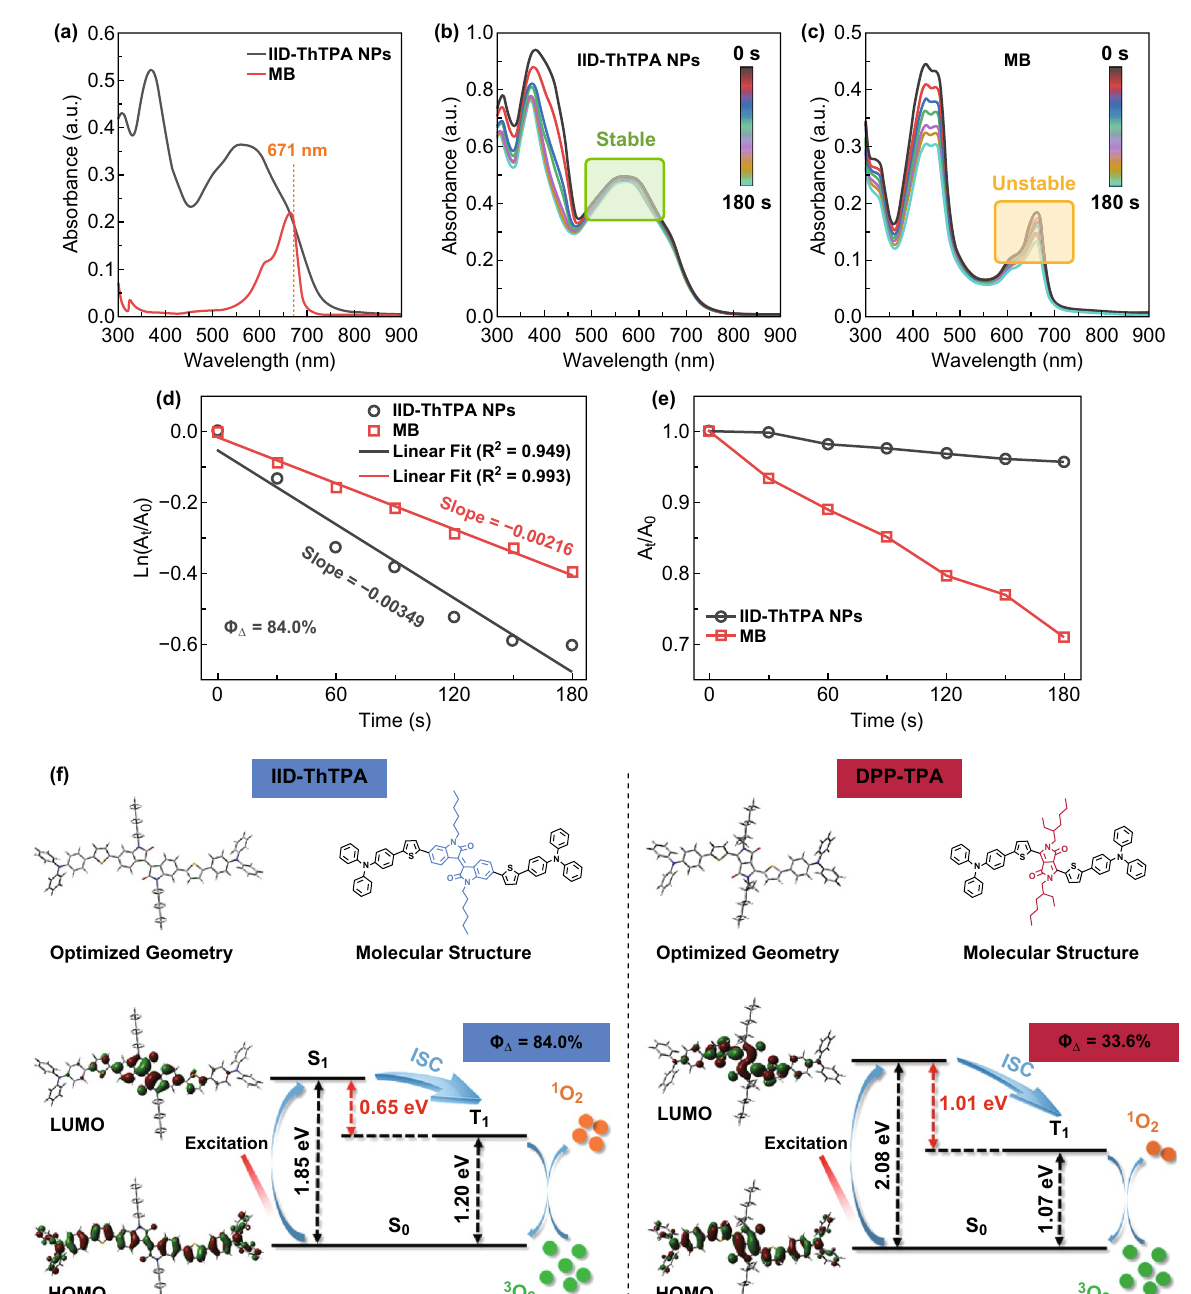
Fig. 3 Singlet oxygen-generating capability of IID-ThTPA NPs. a UV–Vis–NIR absorption spectra of IID-ThTPA NPs and a standard reference MB in water. Degradation of DPBF in the presence of b IID-ThTPA NPs and c MB under laser irradiation. Degradation kinetics of DPBF in the presence of IID-ThTPA NPs and MB under laser irradiation, where d A 0 and A t are the characteristic absorbance of DPBF at 410 nm before and after laser irradiation, respectively; e A 0 and A t are the absorbance at 580 nm (IID-ThTPA NPs) or 665 nm (MB) before and after laser irradia- tion, respectively. f DFT-calculated optimized geometries, HOMOs, LUMOs, S 1 , and T 1 energy levels of IID-ThTPA and a previously reported conjugated small molecule DPP-TPA to depict the ultrahigh singlet oxygen quantum yield of IID-ThTPA